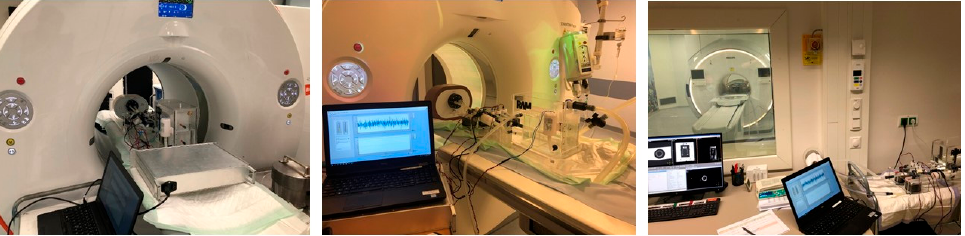
Figure 3. Example of the overall phantom measurement setup in PET/CT ( left ), CT ( middle ) and MRI ( right ).